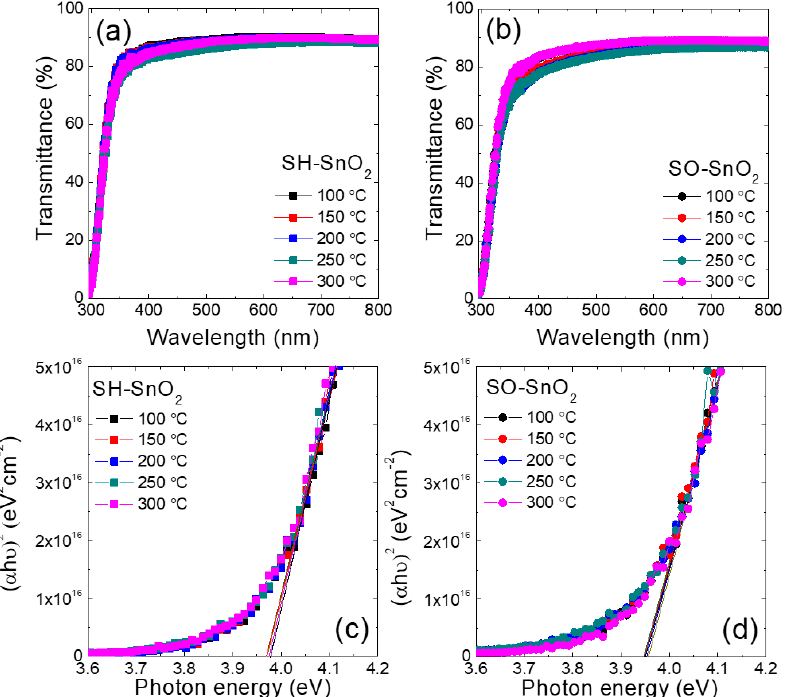
Figure 5. Optical transmittance of 20-nm-thick ( a ) SH-SnO 2 films and ( b ) SO-SnO 2 films deposited on a soda-lime glass substrate at 100–300 °C. Optical band gaps of ( c ) SH-SnO 2 and ( d ) SO-SnO 2 films grown at 100–300 °C.